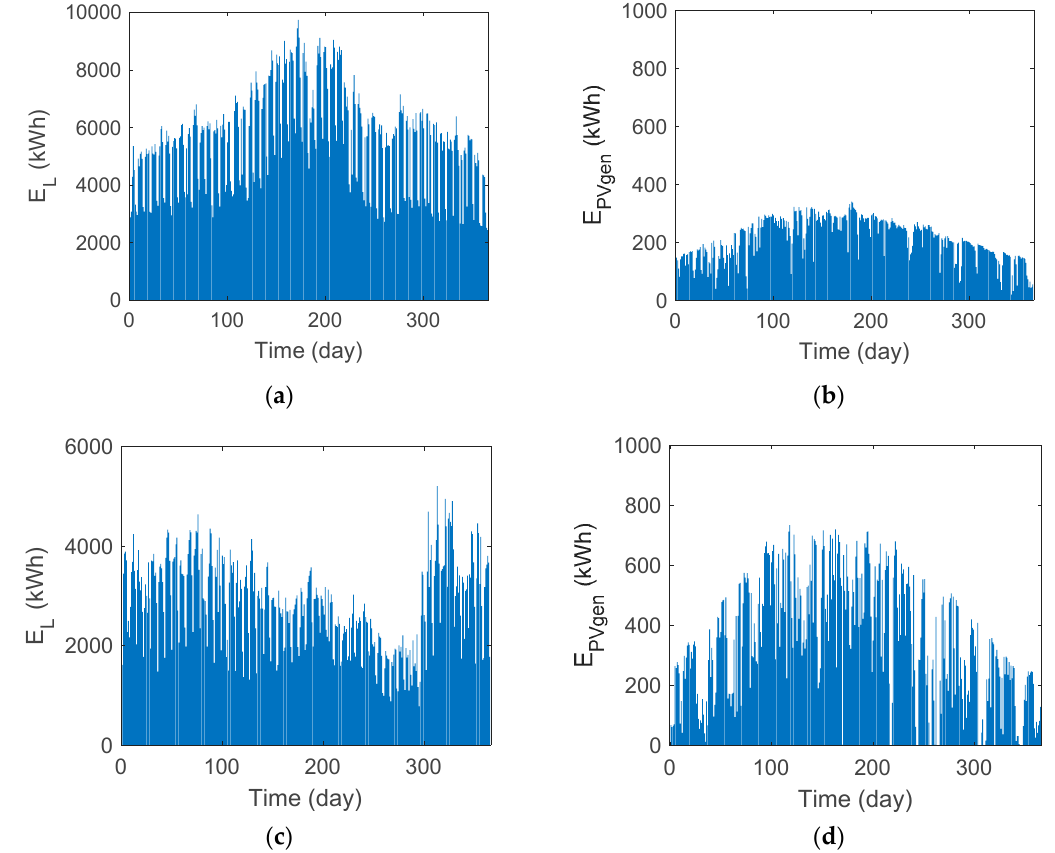
Figure 2. Bar graphs with one bar for cumulative daily consumption and photovoltaic generation (kWh/day) corresponding to industry A and B throughout a year (365 bars). ( a ) Industry A-Daily consumption data; ( b ) Industry A-Daily generation data; ( c ) Industry B-Daily consumption data; ( d ) Industry B-Daily generation data.